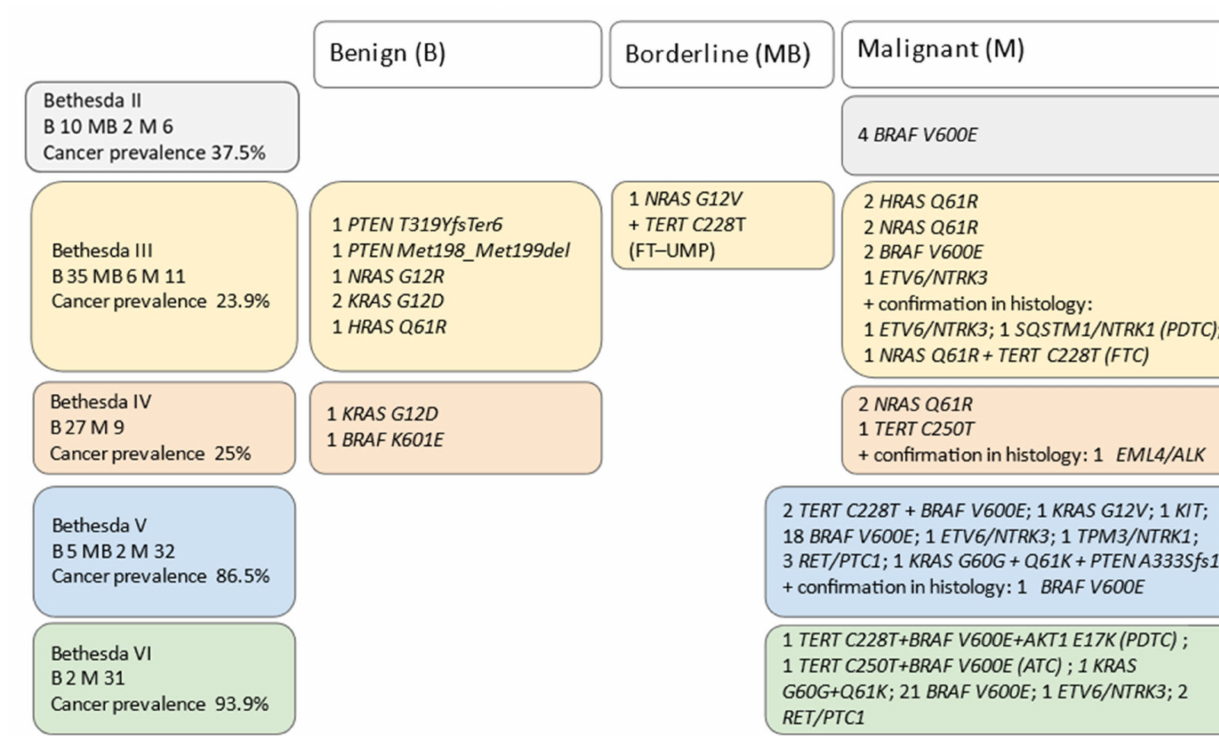
Figure 3. Bethesda System for Reporting Thyroid Cytopathology results with cancer prevalence in particular groups concurrently with molecular testing. Benign (B), borderline (MB), and malignant (M) cohorts of patients were determined by histology. M cohort consisted especially of PTC; other tumor types are pointed out. Cancer prevalence was calculated as the number of people with TC in each group of patients according to Bethesda categories (excluding MB).FT-UMP—follicular tumor of uncertain malignant potential; ATC—anaplastic thyroid cancer; PDTC—poorly differentiated thyroid cancer and FTC follicular thyroid cancer.